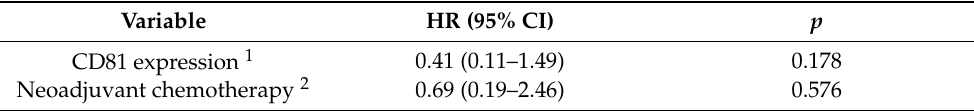
Figure 3. Kaplan–Meier Curves for DFS, according to CD81 status ( n = 105). ( a ) In total, 77% of the CD81 negative patients showed cancer relapse, while 23% of relapse was recorded among CD81 positive patients ( p = 0.004). The total number of patients with cancer relapse was 34 (100%). ( b ) Neoadjuvant chemotherapy analysis, including 8 treated and 25 non-treated relapsed VSCC patients ( p = 0.022) ( n = 33 *). p -value was determined using the log-rank test, which refers to the corresponding expression status. * One patient was excluded due to lack of treatment information. Table 4. Multivariate proportional hazard analysis of the neoadjuvant chemotherapy status and CD81 protein